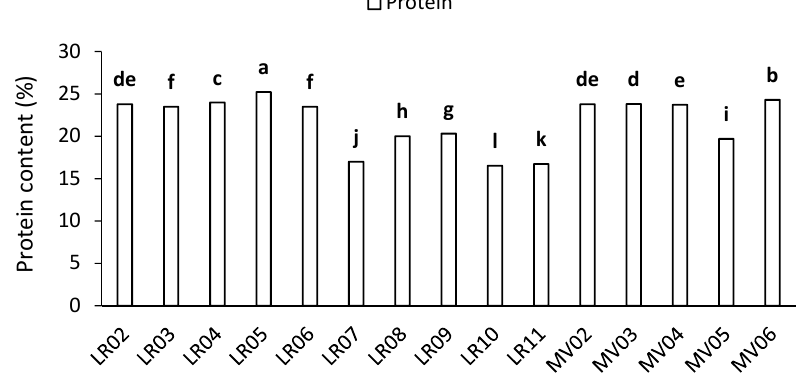
Figure 1. Crude protein of landraces (LR) and modern varieties (MV). Means followed by the same lower-case letters are not significantly different (Duncan’s multiple range test (DMRT); p < 0.05).